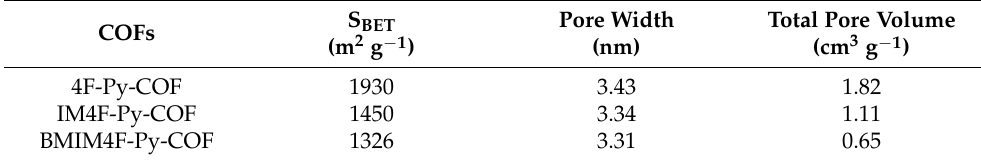
Figure 4. N 2 adsorption-desorption isotherms ( a ) and their pose size distribution of IM4F-Py-COF ( b ), BMIM4F-Py-COF ( c ), and 4F-Py-COF ( d ) recorded at 77 K, respectively. Table 1. Porous properties of 4F-Py-COF, IM4F-Py-COF, and BMIM4F-Py-COF.